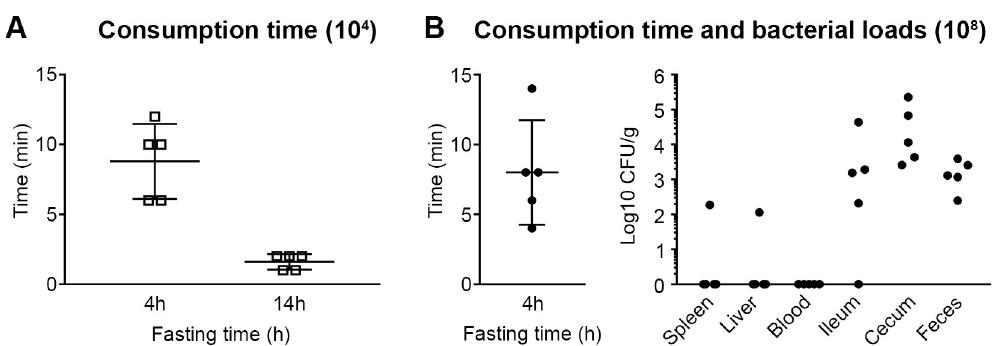
Fig 6. Fasting duration affects consumption time and bacterial loads. (A) Time required for mice to completely consume fragments of chow with the indicated inoculum and fasting time. Symbols represent individual mice and error bars represent the mean ± SD. 5 mice per experiment. (B) Consumption time (left panel) and bacterial loads (right panel) in tissues 3 days p.i. following 4 h of fasting and an inoculum of 10 8 CFU Salmonella . n = 5 mice, symbols represent individual mice, error bars represent the mean ±